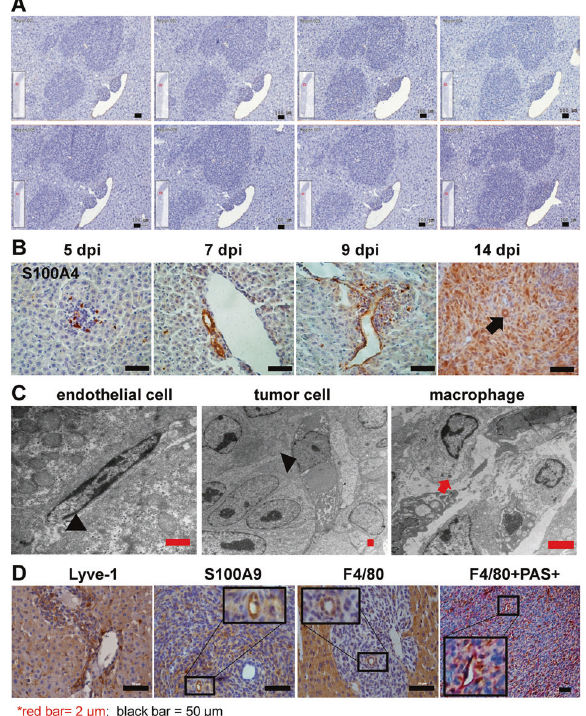
Fig. 3 F4/80 + macrophages were highly linked to CRLM-adopted liver vessel co-option and VM tubes on tumor vascularization. A IHC with an anti-CD34 antibody staining on serial tissue sections of CRLM at 14 dpi displayed 3-D versions of the CD34 + tumor mass grown along an innate liver vessel (the elliptical white space). B IHC staining on S100A4 + cells showing the tumor cells formed tubular structures in a VM manner during disease progression; the arrow showed circular staining with 14 dpi CRLM. C